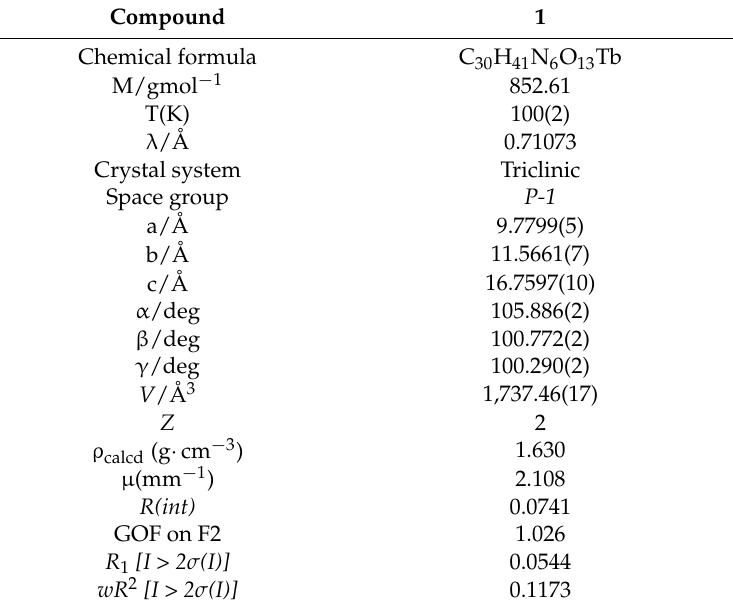
Table 1. Crystallographic data and structural refinement details for 1